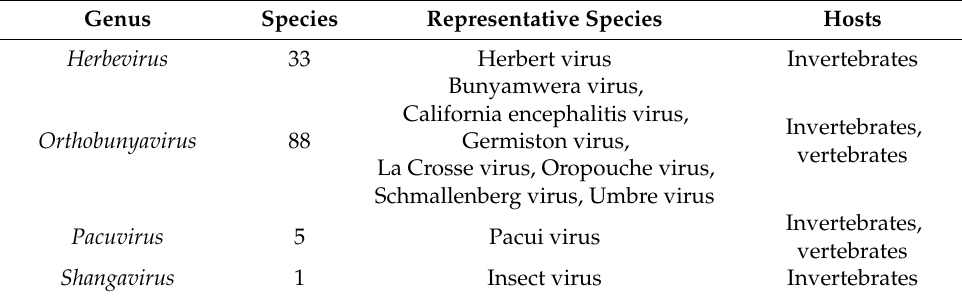
Table 1. Classification within the family Peribunyaviridae